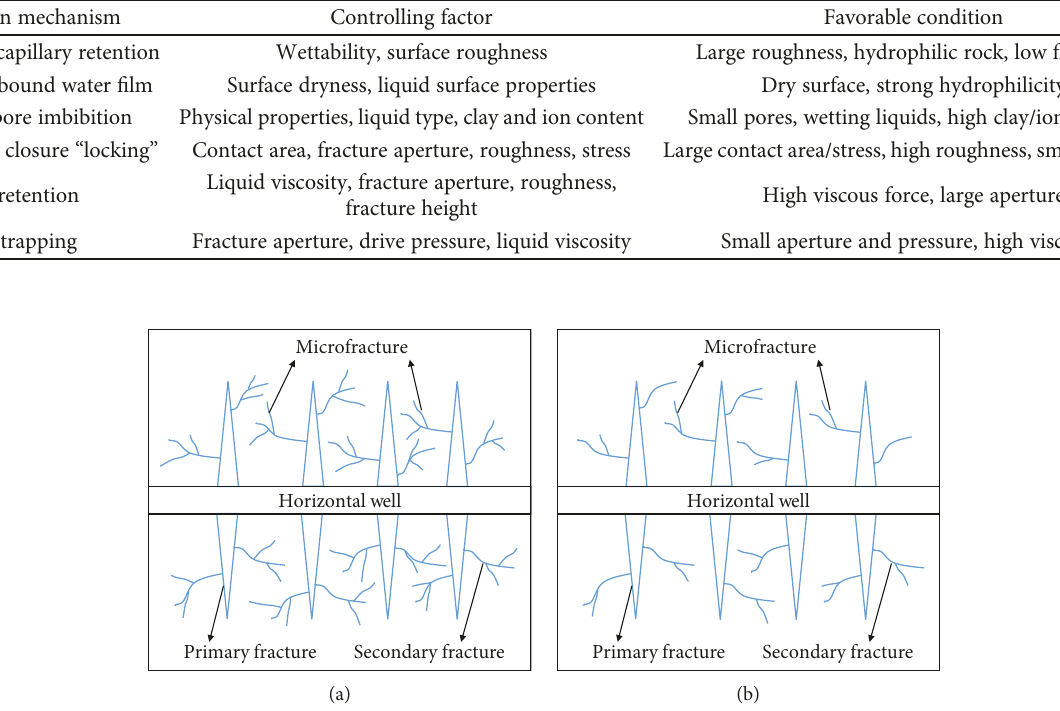
Figure 19: Comparison of fractures: (a) complex fractures and (b) simple fractures (modi fi ed from Ghanbari and Dehghanpour